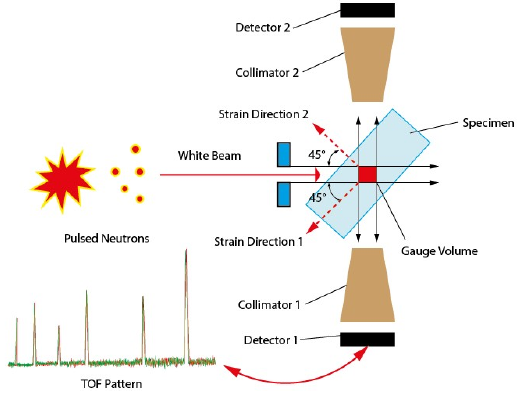
Figure 6. Schematic of time-of flight method.